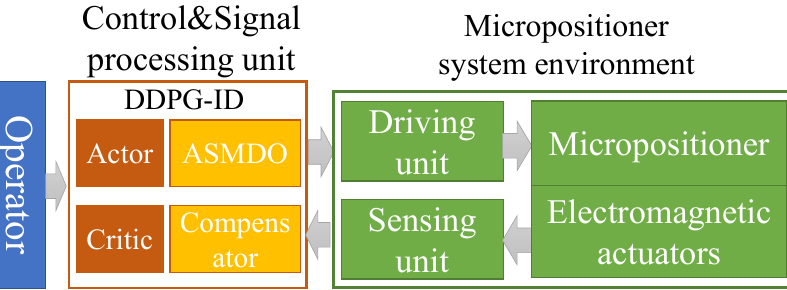
Figure 3. System signal flow